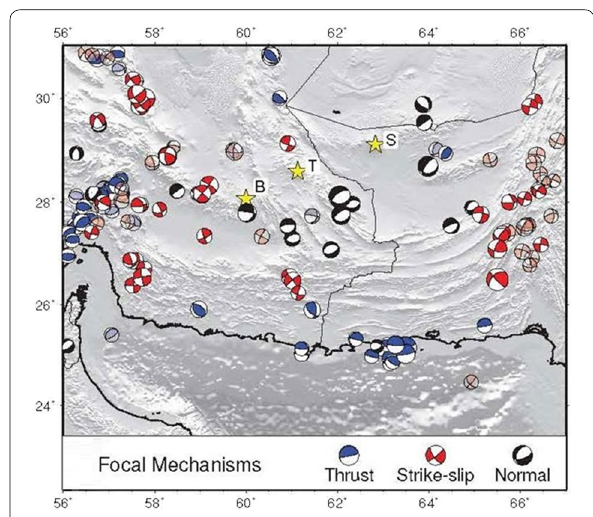
Fig. 4 Focal mechanism of earthquakes, mb > 4, from 1945 to 2013 from GCMT or in the literature. The earthquake for which the focal mechanism is poorly constrained is shown as semi-transparent (B, T, S are the volcanic arcs Bazman, Taftan and Sultan) (Penney et al.